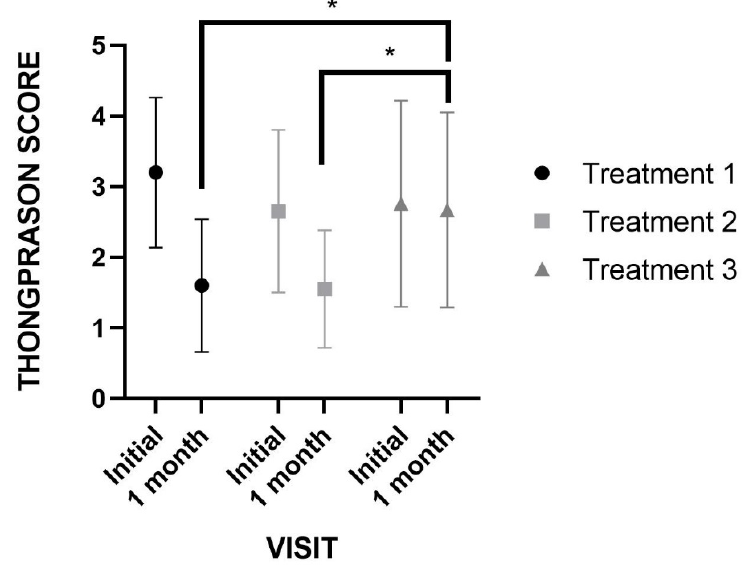
Figure 2. Thongprasom score, change from Baseline-1 month (Score 0–5). * p <